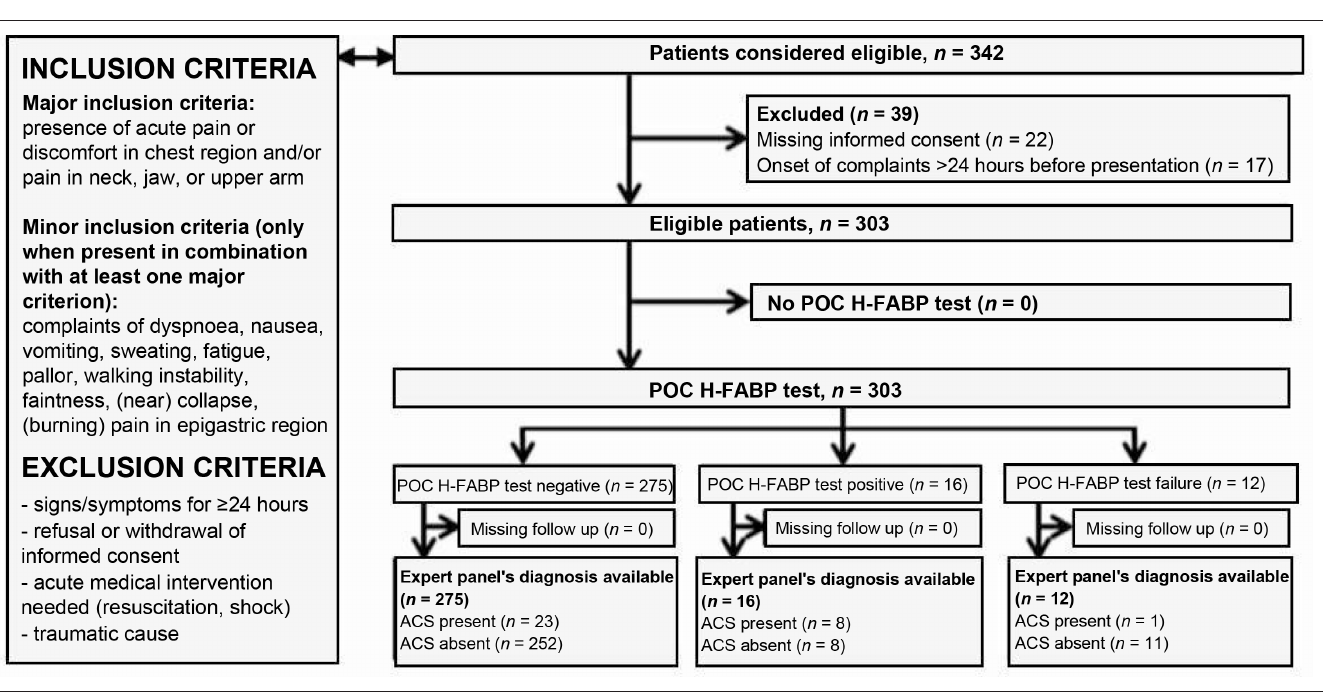
Figure 1 Study flow chart showing inclusion and exclusion criteria, and eligible participants with numbers of main outcome (ACS). ACS = acute coronary syndrome. H-FABP= heart-type fatty acid-binding protein. POC = point of